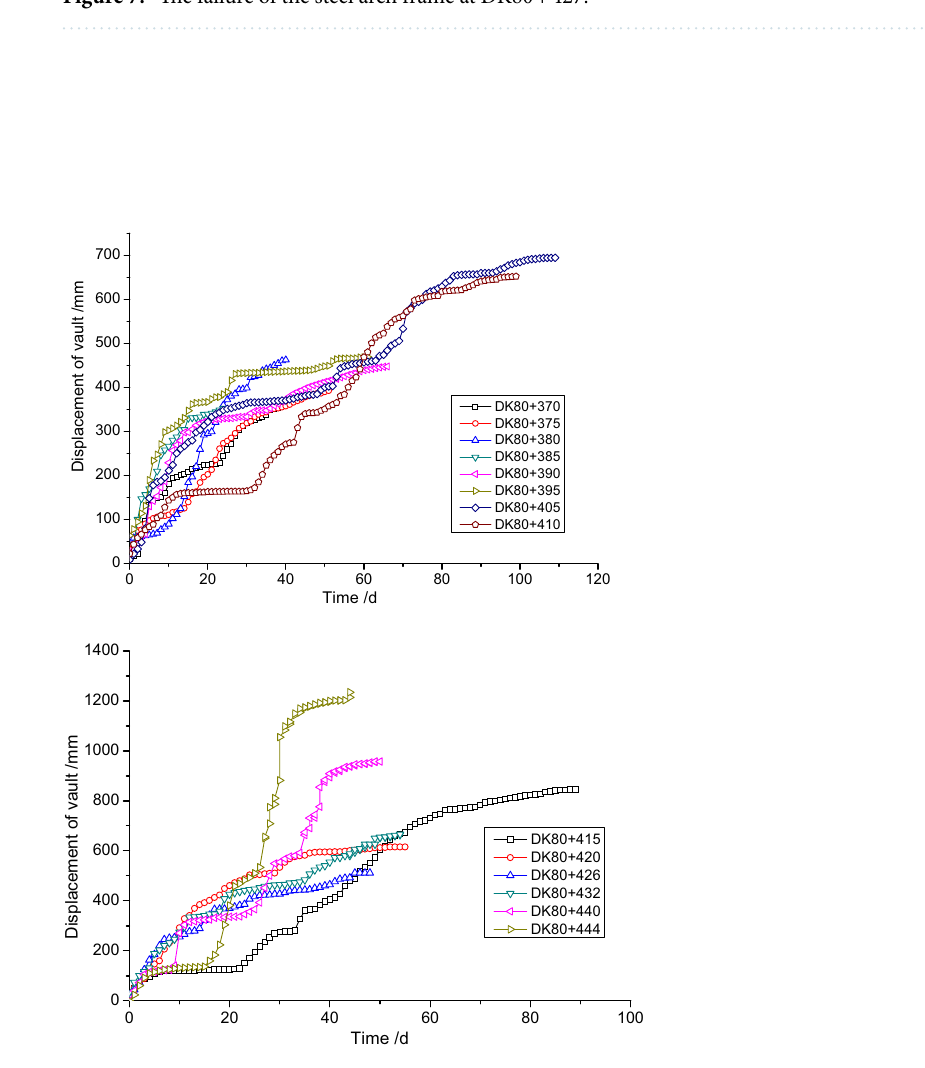
Figure 8. Monitoring data for the settlement of the vault at some large deformation sections in the